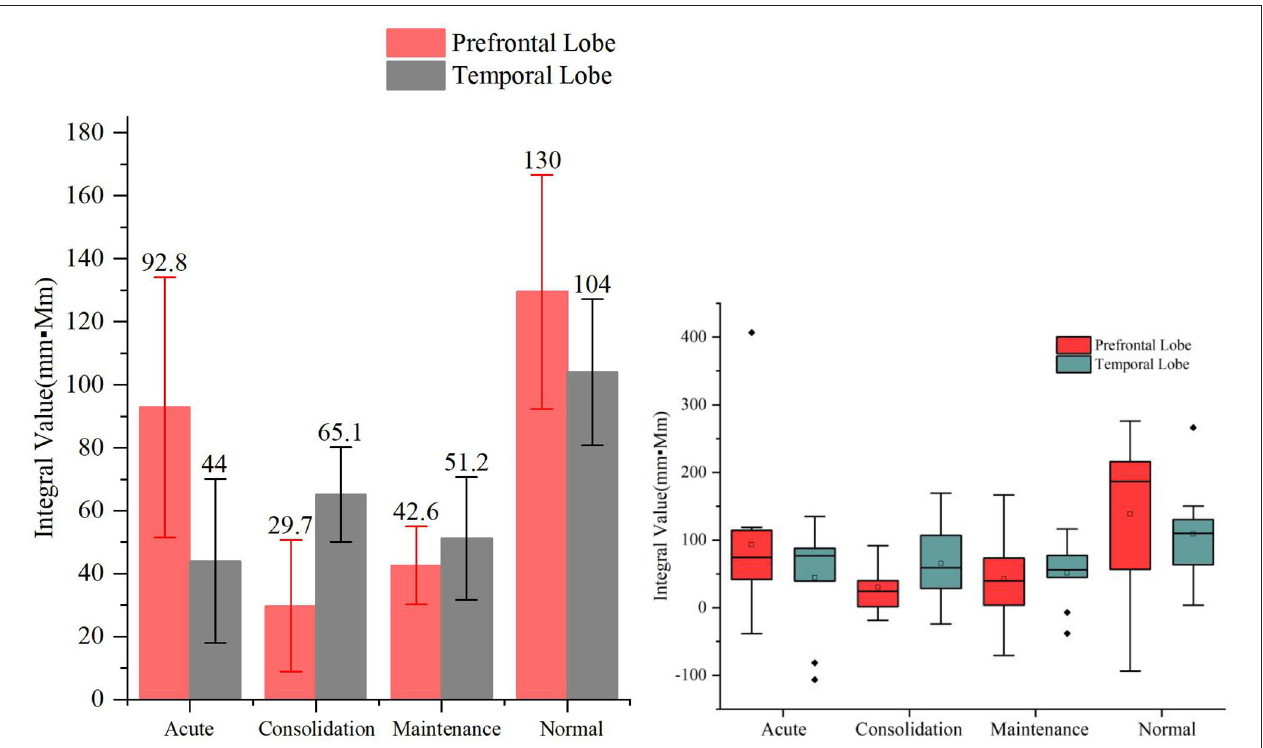
FIGURE 5 | Integral values (mean ± SD) of prefrontal and temporal oxy-Hb from the anxiety and depression patients at the acute, consolidation, and maintenance stages as well as the healthy controls during the verbal fluency task. No significant differences were found in the oxy-Hb integral values among the four